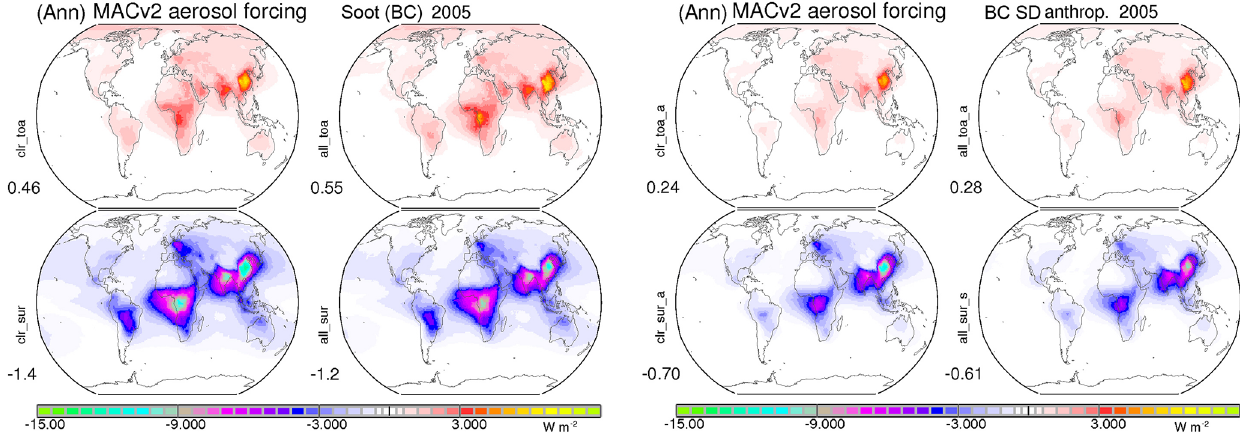
Figure E4. Annual maps for present-day radiative effects of total (left frame) and anthropogenic (right frame) for soot (or BC). Each block displays impacts for clear-sky (left column) and all-sky conditions (right column) at both TOA (top row) and surface (bottom row). Blue colors indicate a cooling (at the surface) and red colors a warming (at the TOA). Values below the labels are global averages.